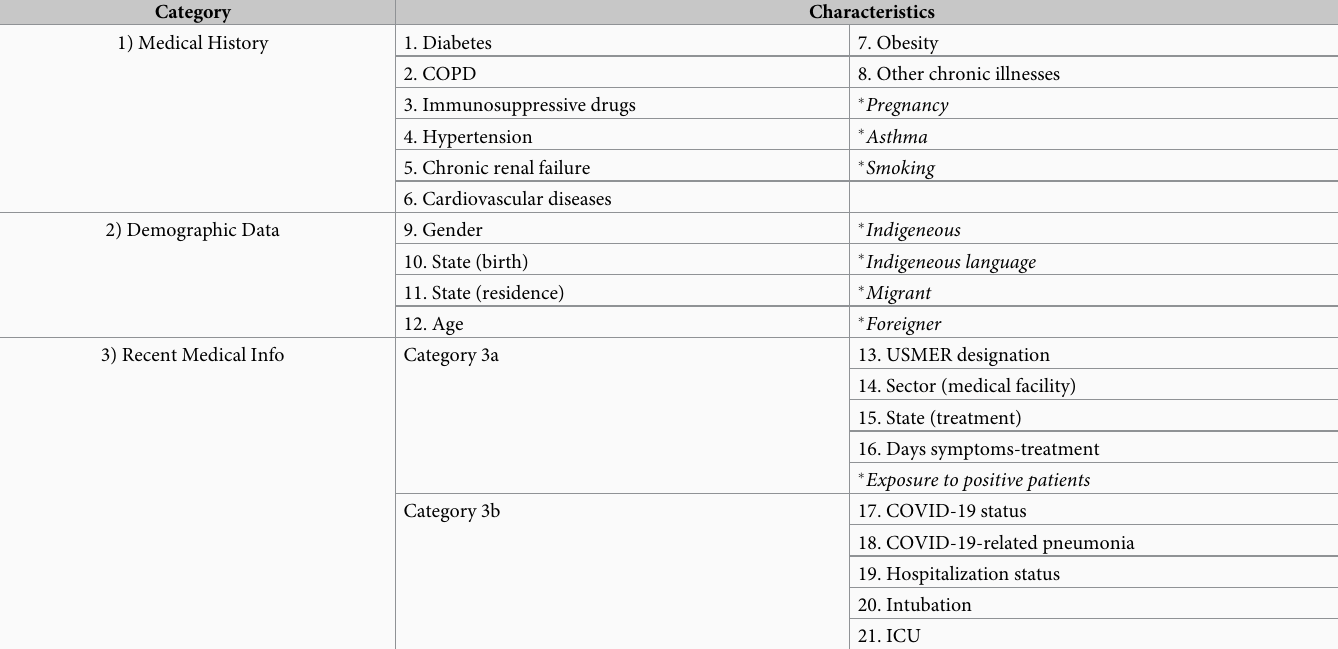
Table 2. Classification of characteristics. Characteristics shown in italic font do not exhibit a sufficient predictive power and are therefore not included in our subsequent analysis. We have divided the clinical treatment into four clinical stages to test our neural networks. Stage 1 corresponds to those patients who are in the process of receiv- ing initial medical assessment; therefore, characteristics in categories 1,2, and 3a are assigned. For patients in stage 2, the COVID-19 status and pneumonia characteristics are added to the characteristics vector. When a decision has been made as to whether admit a patient into a hospital or send him/her back home, the hospitalization status characteristic is added at Stage 3. Finally, Stage 4 includes the intubation and ICU characteristics for those patients in critical condition. Category